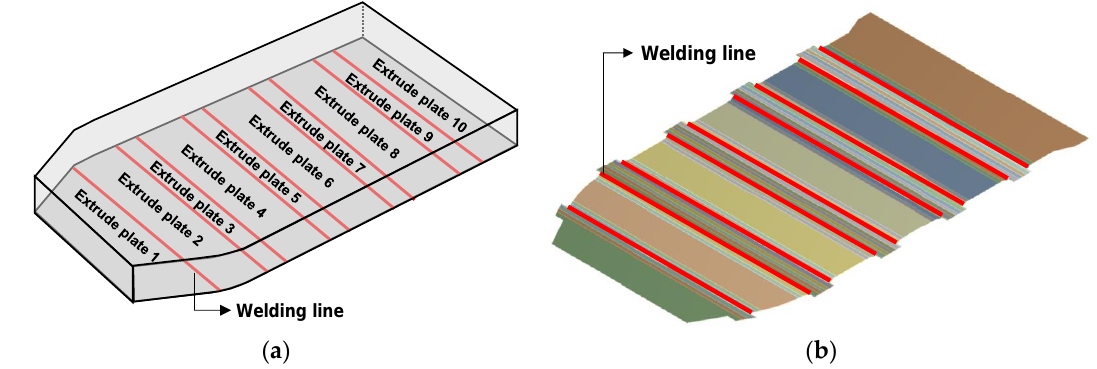
Figure 14. Aluminum battery housing model: ( a ) conceptual diagram of structure; ( b ) FE model of the bottom plate.